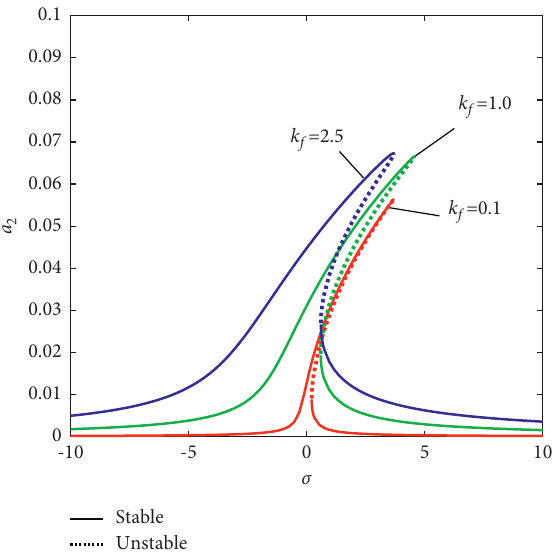
Figure 28: The effect of ratio of length to diameter on frequency response curve ( θ � 0 ° , c � 0.01, case II).